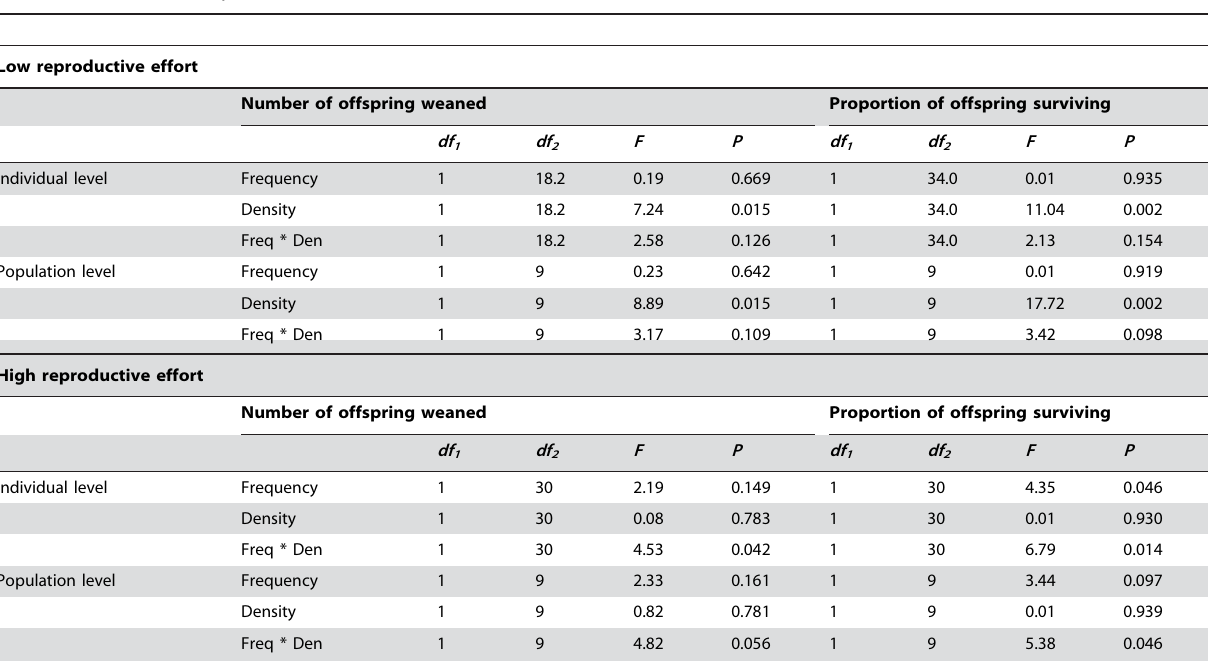
Table 1. The effects of frequency and density on number of offspring weaned, and proportion of offspring surviving until weaning in different tactics of reproductive